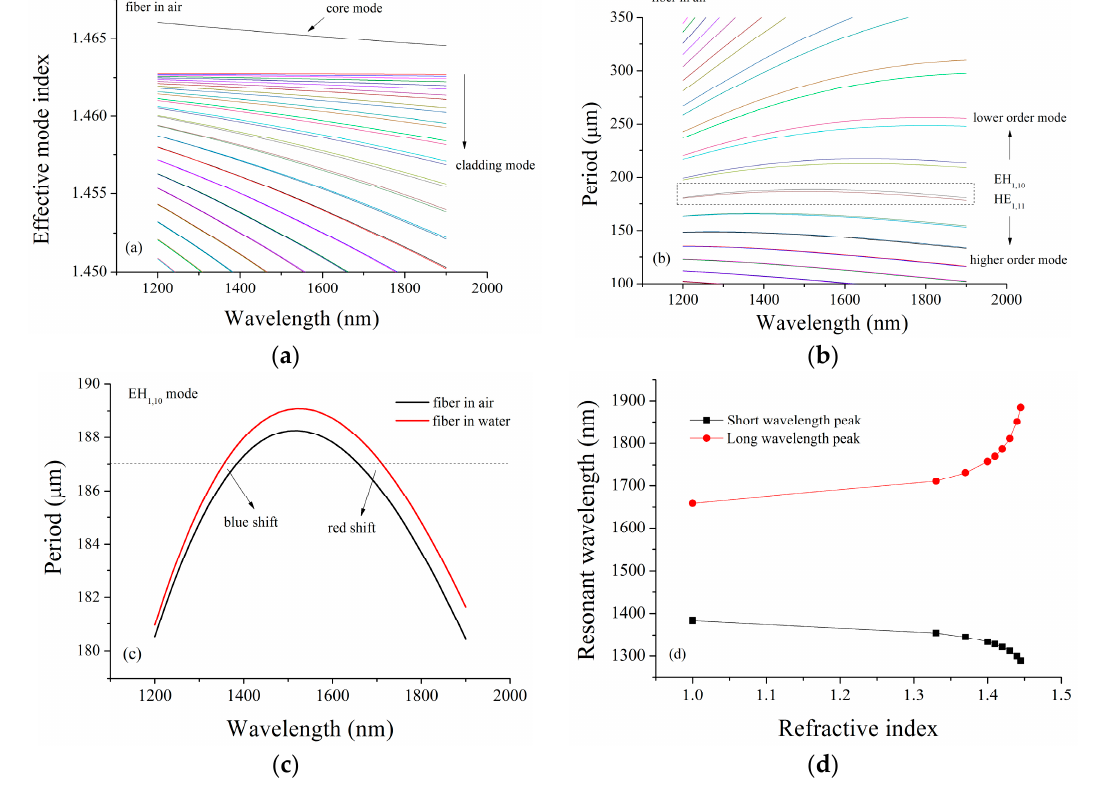
Figure 6. Schematic diagram of theoretical simulation: ( a ) a core mode and a series of cladding modes supported in the fiber; ( b ) the relation between period and order mode; ( c ) the relation between period and wavelength; ( d ) the relation between the resonant wavelength and RI.